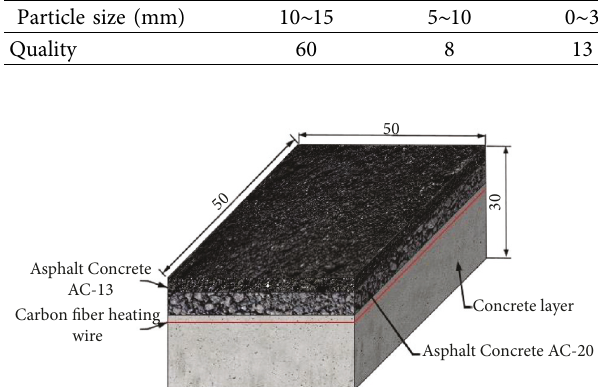
Figure 4: Layout of the heating wire (unit: